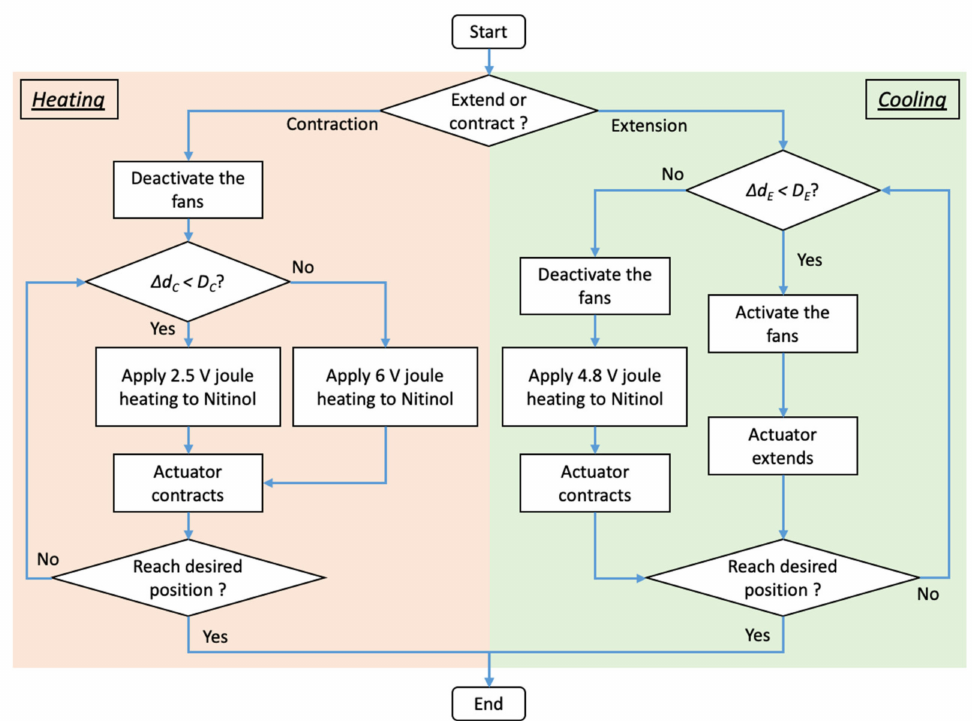
Figure 3. The flowchart of the two-state discrete antagonistic actuator